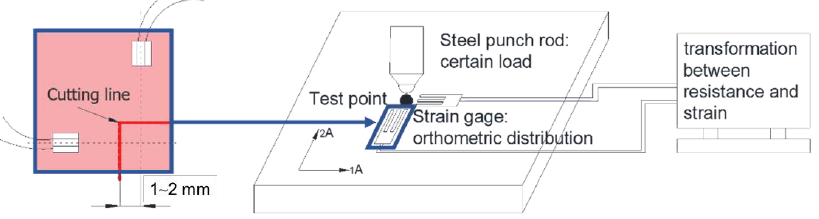
Figure 3. The measurement principle of indentation strain gauge method.